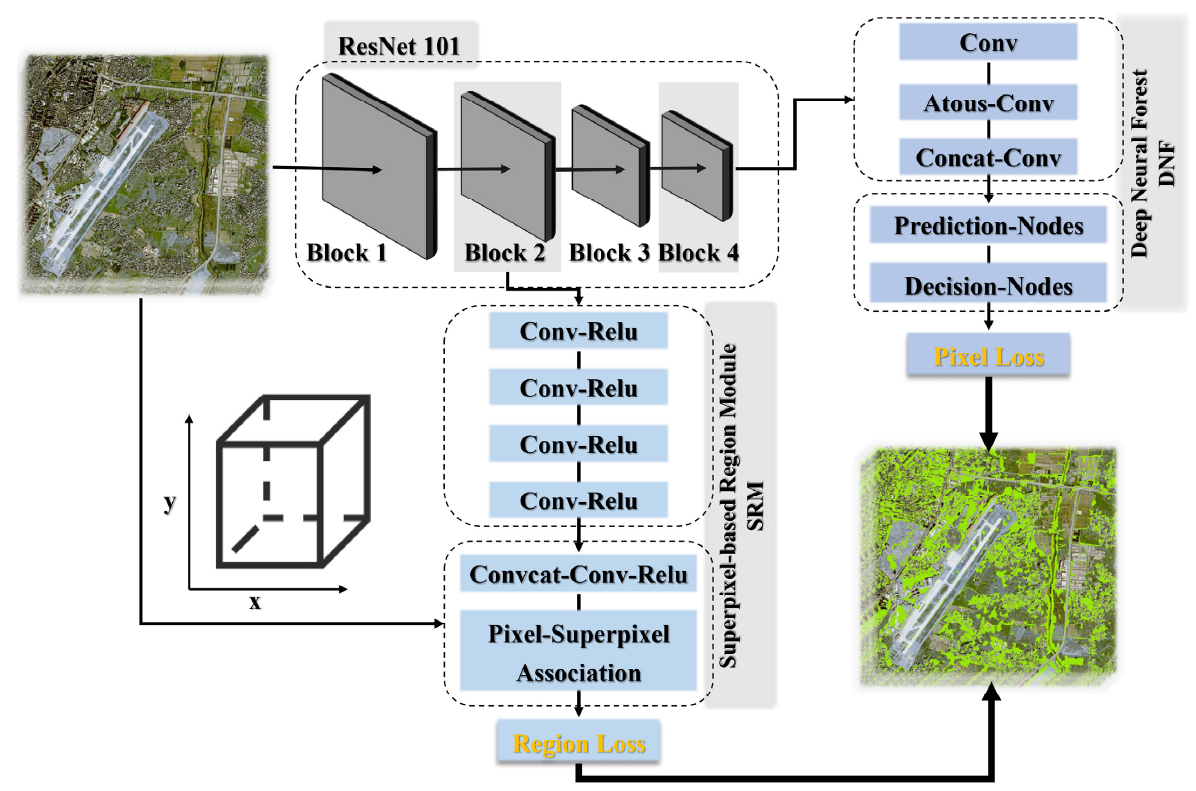
Figure 2. The structure of SDNF model.